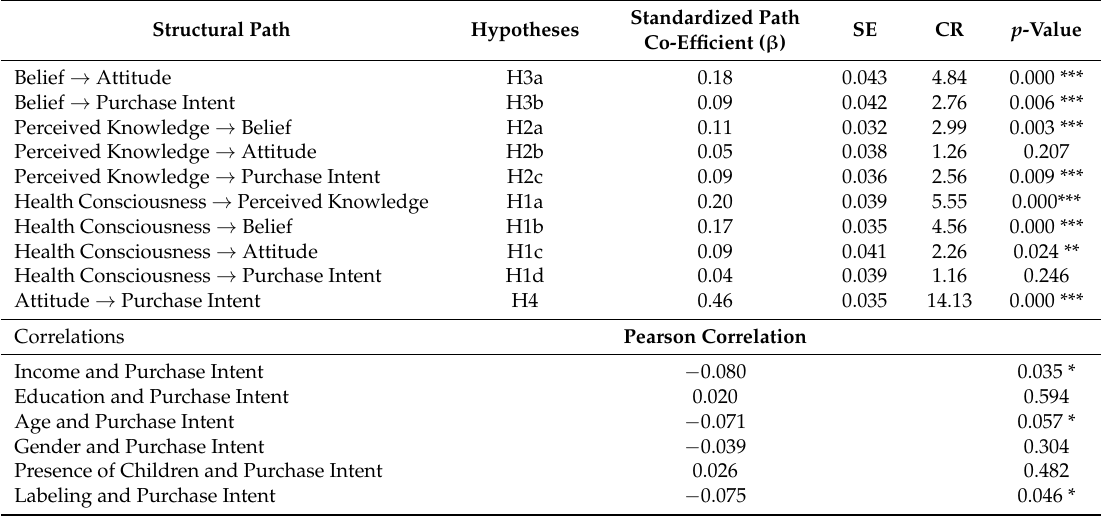
Table 6. Results of structural equation modeling: standardized path